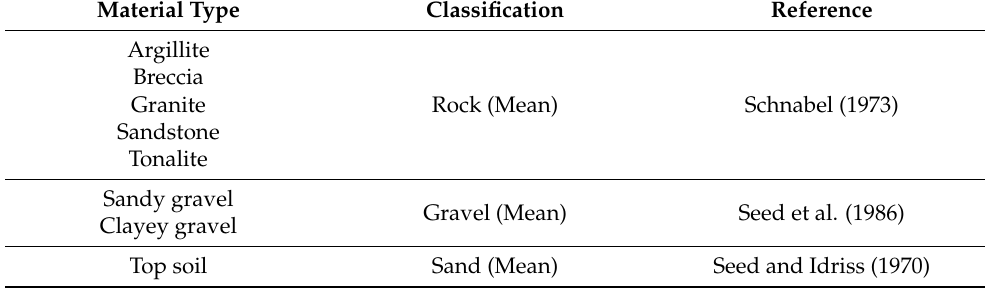
Table 2. Classification and reference according to the material type.